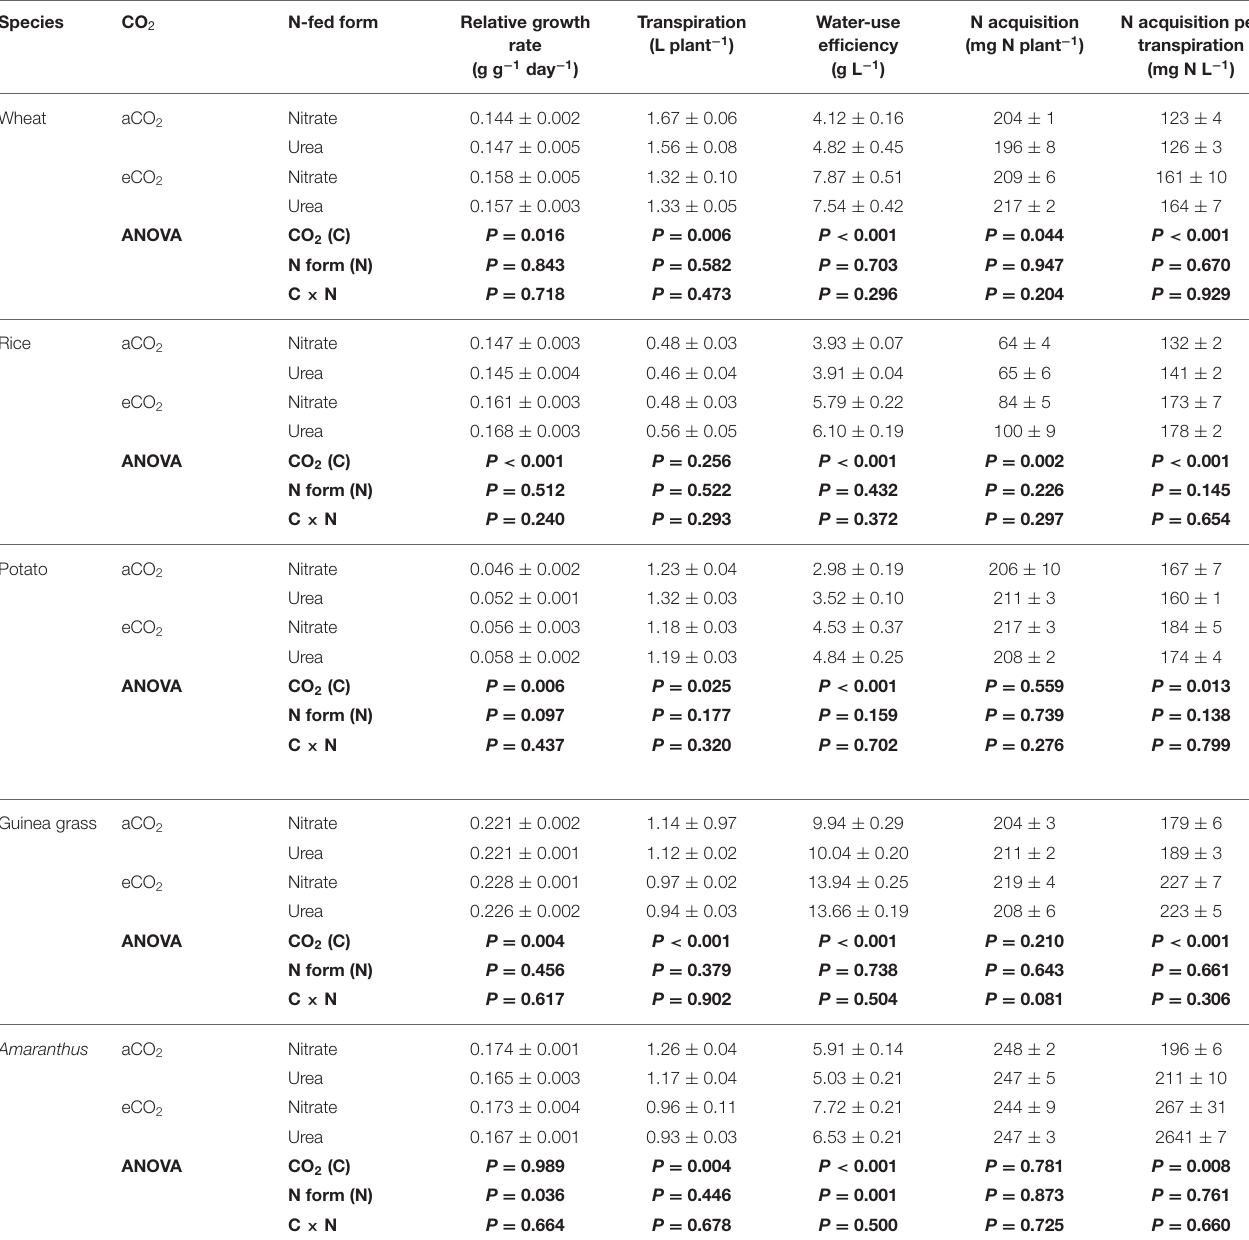
TABLE 1 | Growth parameters of nitrate-fed or urea-fed plants in five species grown for 28 d in the chambers under ambient (aCO 2 ) or elevated (eCO 2 ) CO 2 treatments. Species CO 2